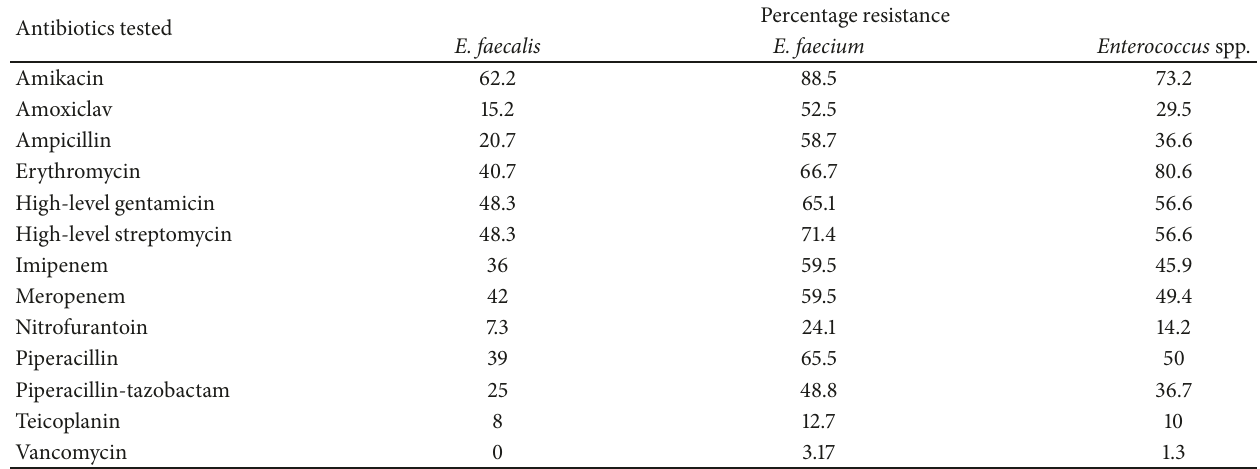
Table 2: Antibiotic resistance pattern of E. faecalis and E. faecium.